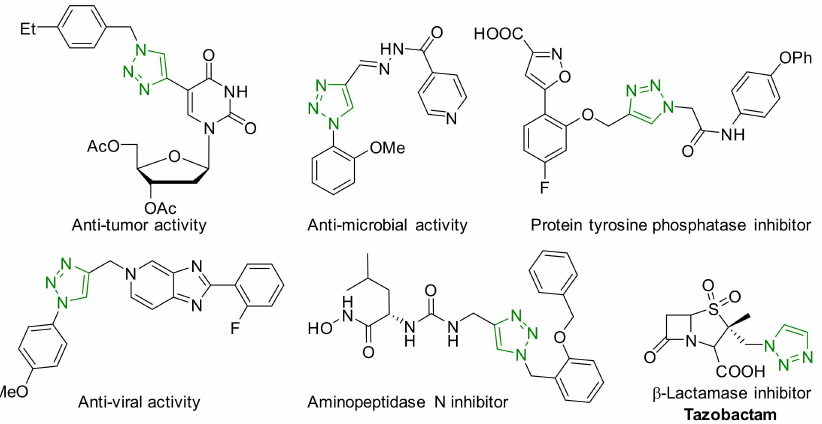
Figure 1. Chemical structures of some 1,2,3-triazole-containing biologically active